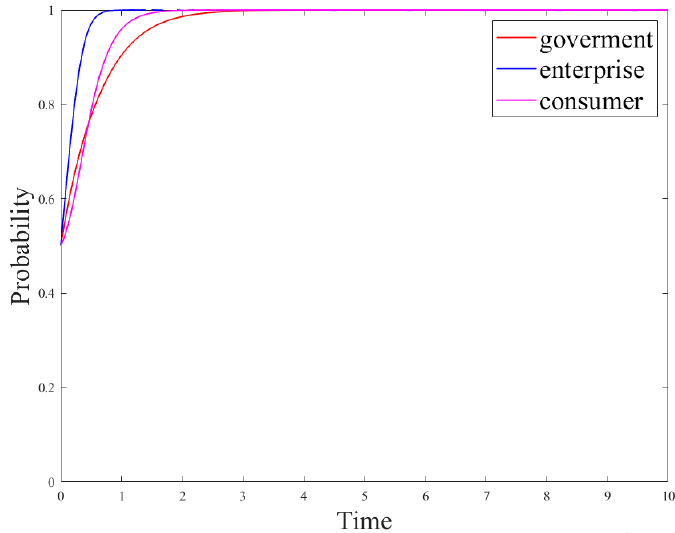
Figure 7. Evolution results under Scenario 3.